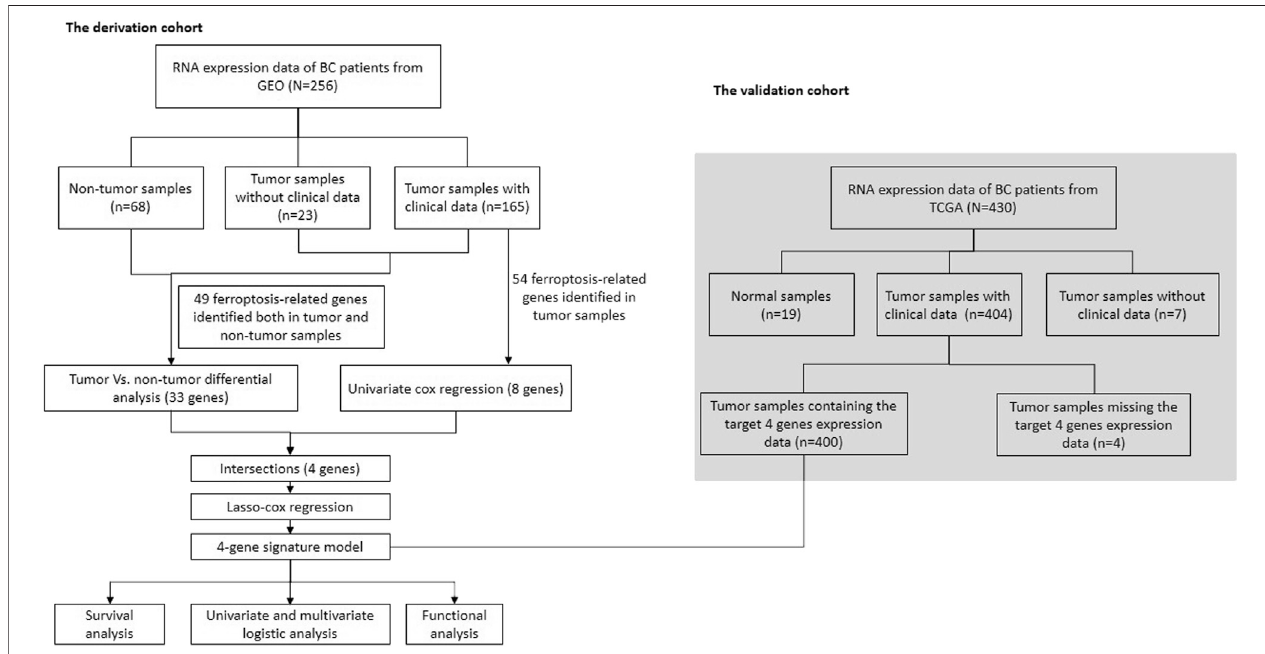
FIGURE 1 | Flow chart for our data selection and analysis.